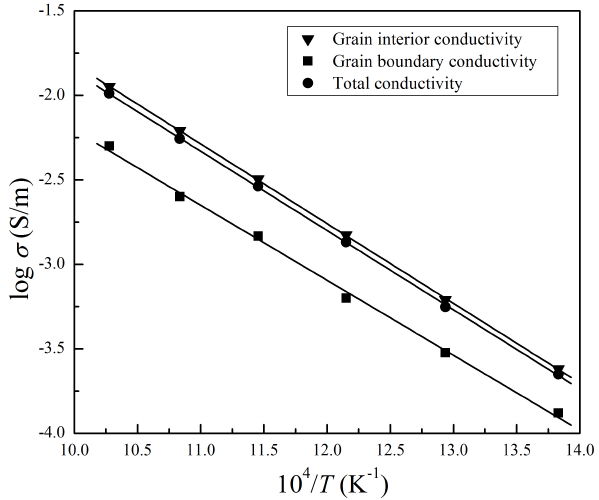
Figure 6. The relationship of grain interior, grain boundary and total conductivity under conditions of 1.0GPa and 723–973K.